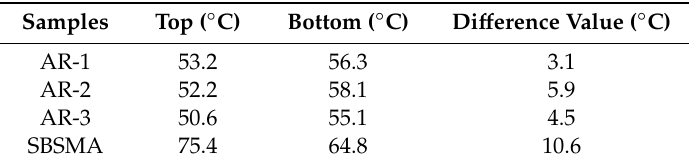
Table 5. Results of storage stability